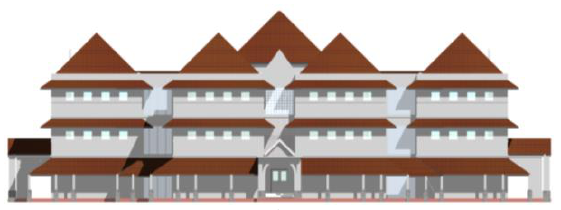
Figure 3. 3D Model of ITB-Jatinangor library